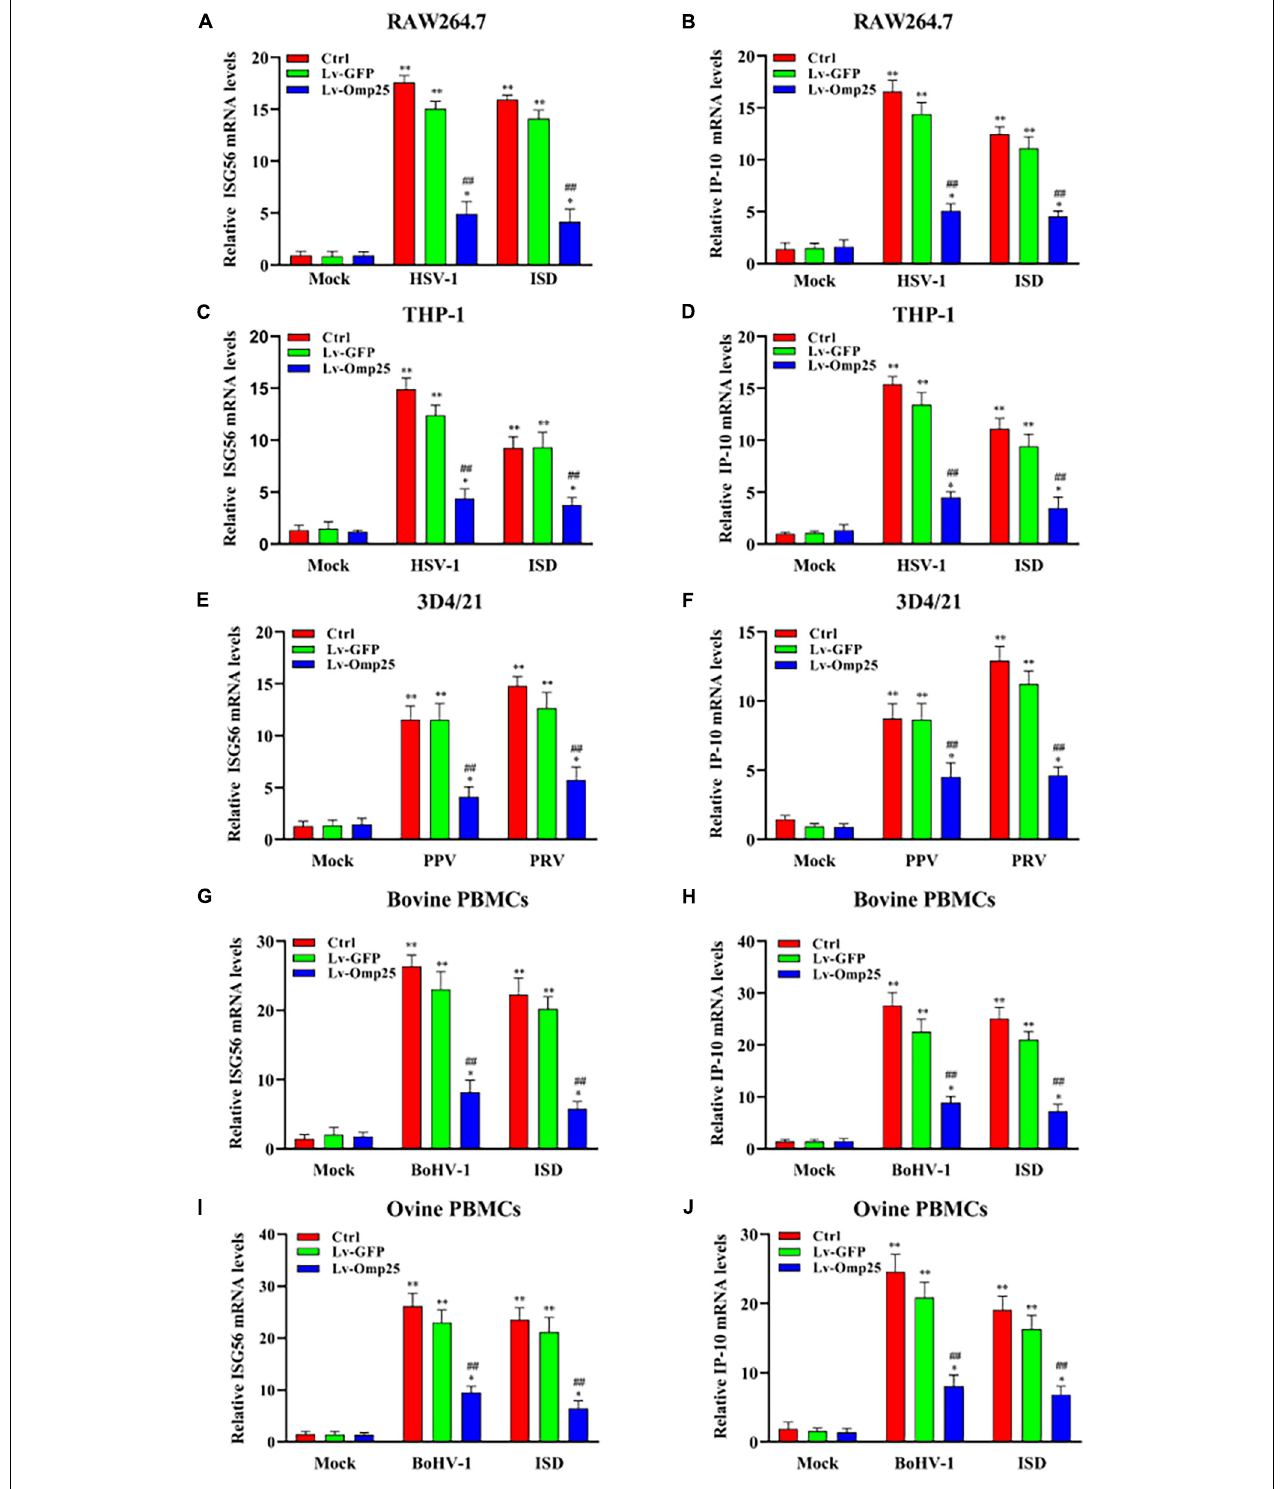
FIGURE 3 | Omp25 inhibits DNA virus and ISD-induced ISG56 and IP-10 expression in various mammalian monocyte/macrophages. Cells were infected with 100 MOI of Lv-Omp25 or Lv-GFP for 48 h and then infected with HSV-1 (10 MOI), PPV (1 MOI), PRV (1 MOI), or BoHV-1 (1 MOI) or transfected with ISD (2 µ g/ml) for another 6 h. Cells were harvested and subjected to qRT-PCR analysis to measure ISG56 mRNA levels (A,C,E,G,I) or IP-10 mRNA levels (B,D,F,H,J) . * P < 0.05, ** P < 0.01 versus mock group, # P < 0.05, ## P < 0.01 versus Lv-GFP-infected cells in same groups.